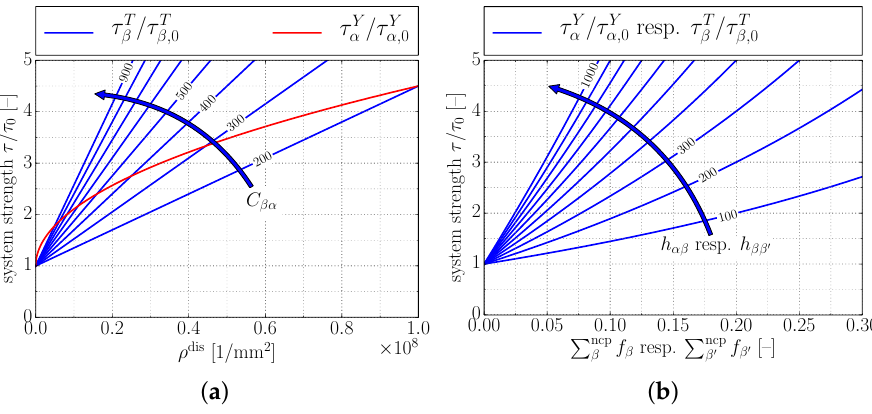
Figure 4. Qualitative illustration of hardening laws, i.e., Equations (24), (25), (27) and (28). ( a ) strengthening of slip systems α and twinning systems β with total dislocation density ρ dis ; influence of interaction coefficient C βα ; ( b ) strengthening of slip systems α and twinning systems β with volume fraction of non-coplanar twins; influence of hardening coefficient h αβ resp. h ββ